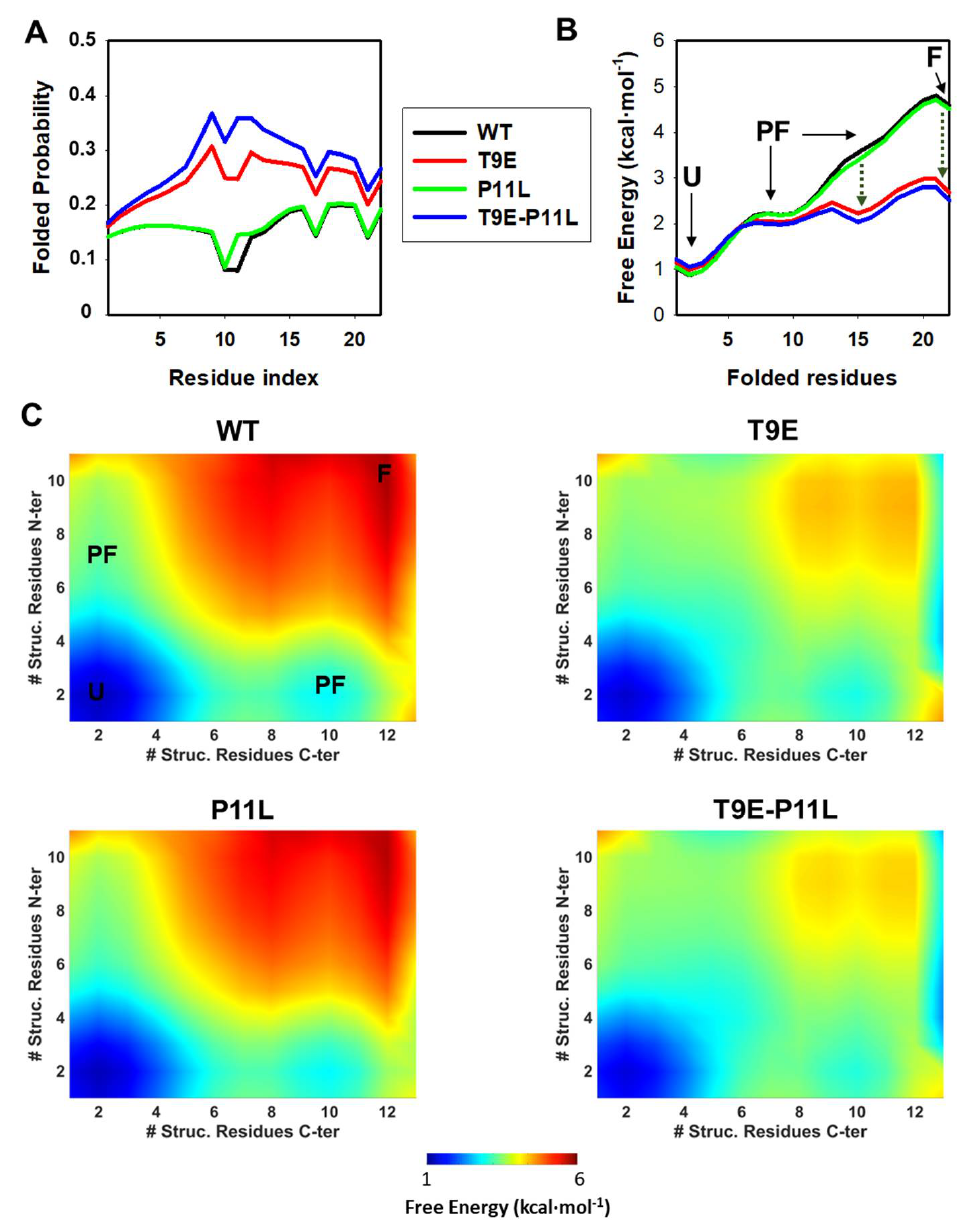
Figure 4. Conformational preferences of NTT-AGT peptides studied by statistical mechanical models. ( A ) Residue level degree of folding (i.e., residue folded probability). ( B ) One-dimensional free energy profiles as a function of the reaction coordinate (i.e., number of folded residues). Four macrostates are observed: one unfolded (U), two partially folded (PF) and a folded (F) state. Stabilization of a PF and the F state by T9E is indicated by vertical, dark green dotted lines. ( C ) Two-dimensional landscapes for the NTT-AGT peptides. The color scale gradually displays the free energy level (from low in blue to high in red). U, PF, and F macrostates are indicated for NTT-AGT-WT. The x and y axis represent the number of structured residues in the N- and C-terminal halves. All calculations were performed at pH 7.0 and 20 °C.